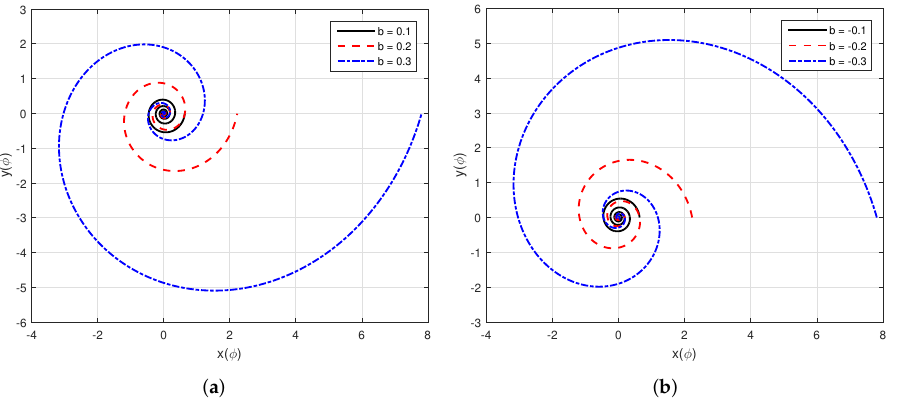
Figure 8. Logarithmic spiral with various values of b : ( a ) logarithmic spiral with positive b values and ( b ) logarithmic spiral with negative b